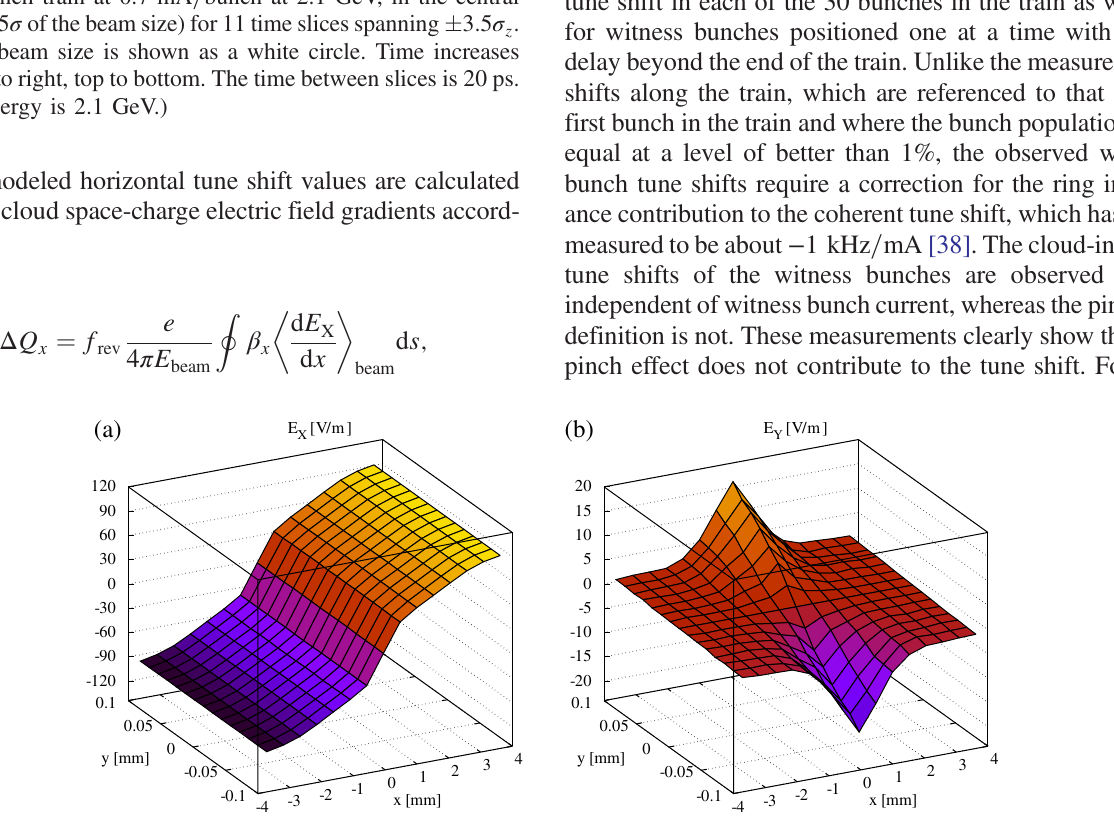
FIG. 23. Space-charge electric field maps (a) E time slice of the last bunch of the 30 bunch train at 0 . 7 mA = bunch at 2.1 GeV, corresponding to the sixth picture in Fig. 22. (Beam energy is 2.1